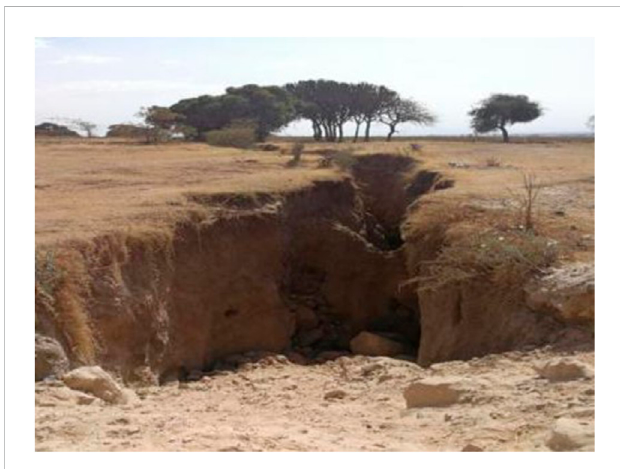
FIGURE 3 Arsi Negele exposed fi ssures.